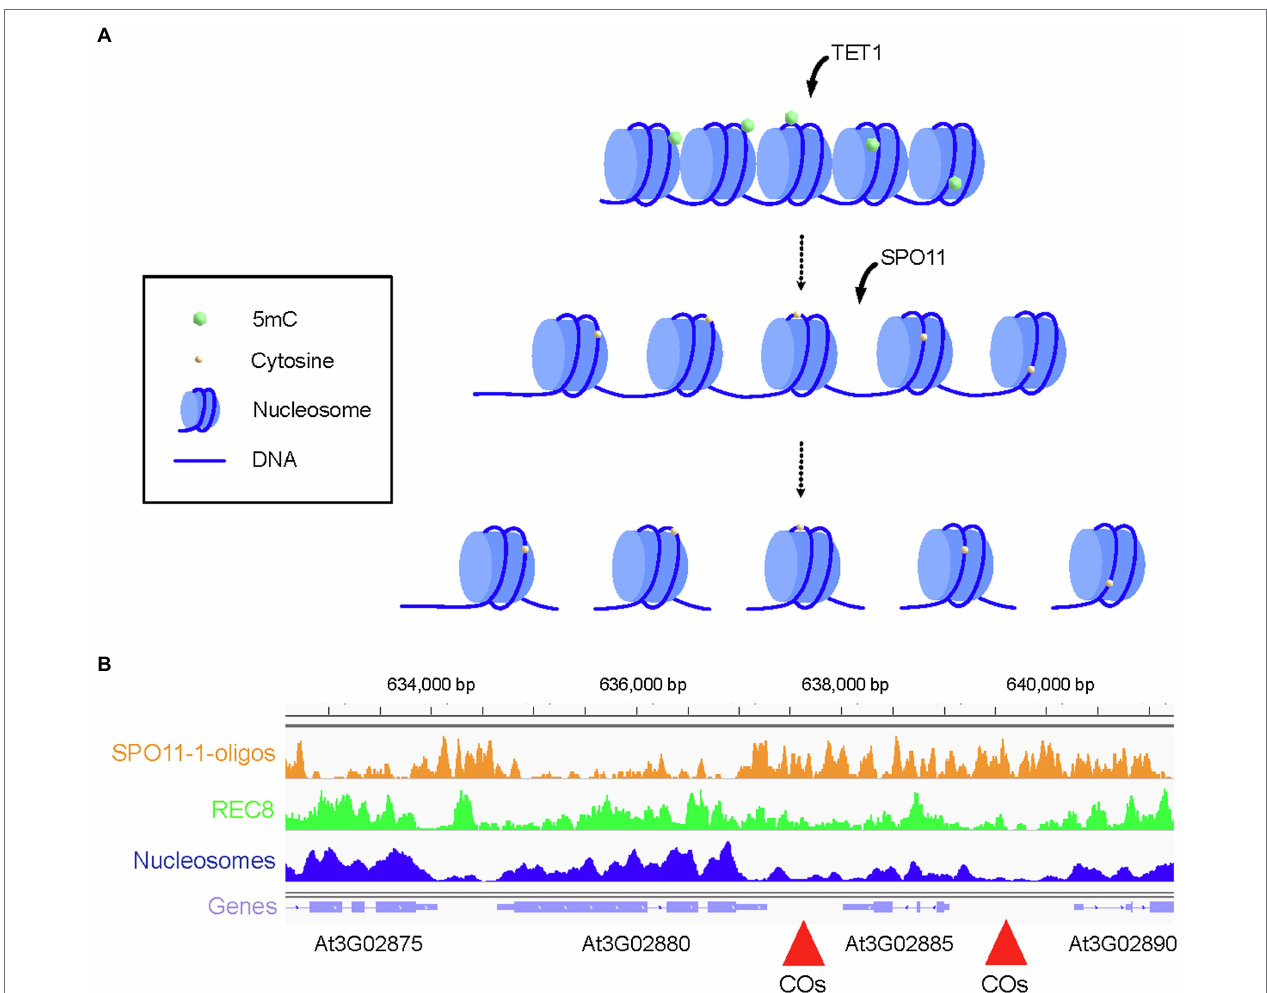
FIGURE 2 | Strategies to remodel the crossover rate locally. (A) Representation of a cold spot region enriched in nucleosome and silencing epigenetic marks, such as DNA methylation in all three contexts (CG, CHG, and CHH). Chromatin is methylated on 5mCs. Targeted recruitment of TET1 catalyzes the removal of silencing epigenetic marks and decompaction of chromatin while the targeted recruitment of SPO11 catalyzes formation of DSBs. Meiotic DSBs are repaired by the homologous recombination pathway leading to the formation of NCO, NCO with gene conversion, or CO. (B) Genome browser view of the crossover hotspot 3a on chromosome 3 of Arabidopsis. SPO11-1-oligo (orange), REC8 ChIP-seq (green), and nucleosome (MNase, dark blue) profiles are shown alongside the gene organization (purple). Regions with high crossover rate are indicated with red arrowheads. Coordinates on the chromosome 3 are shown above the genome browser